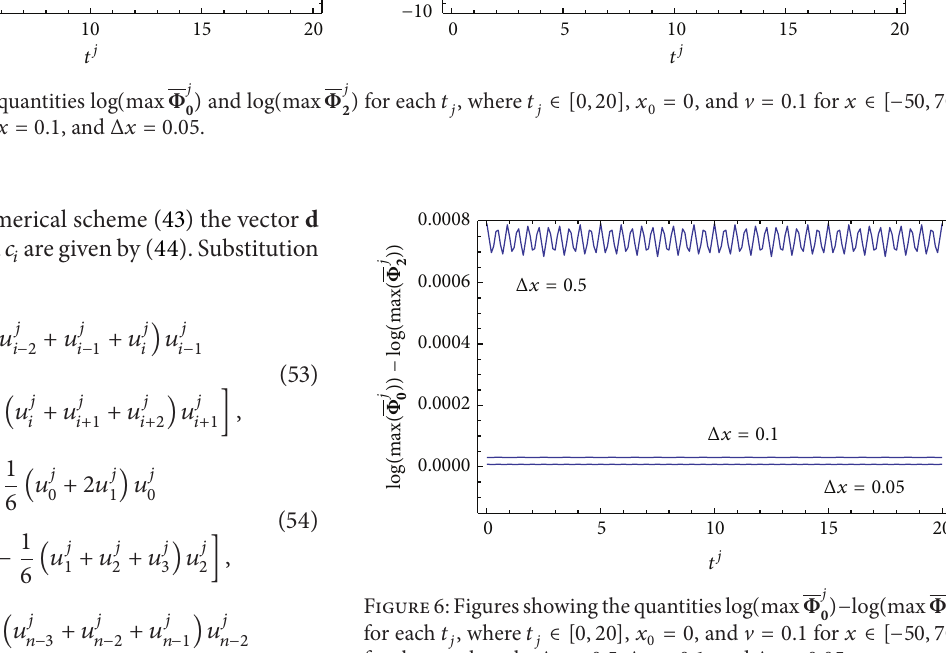
) for each 𝑡 𝑡 ∈ [0, 20] , 𝑥 = 0 , and V = 0.1 for 𝑥 ∈ [−50, 70] 𝑗 , where 𝑗 0 2